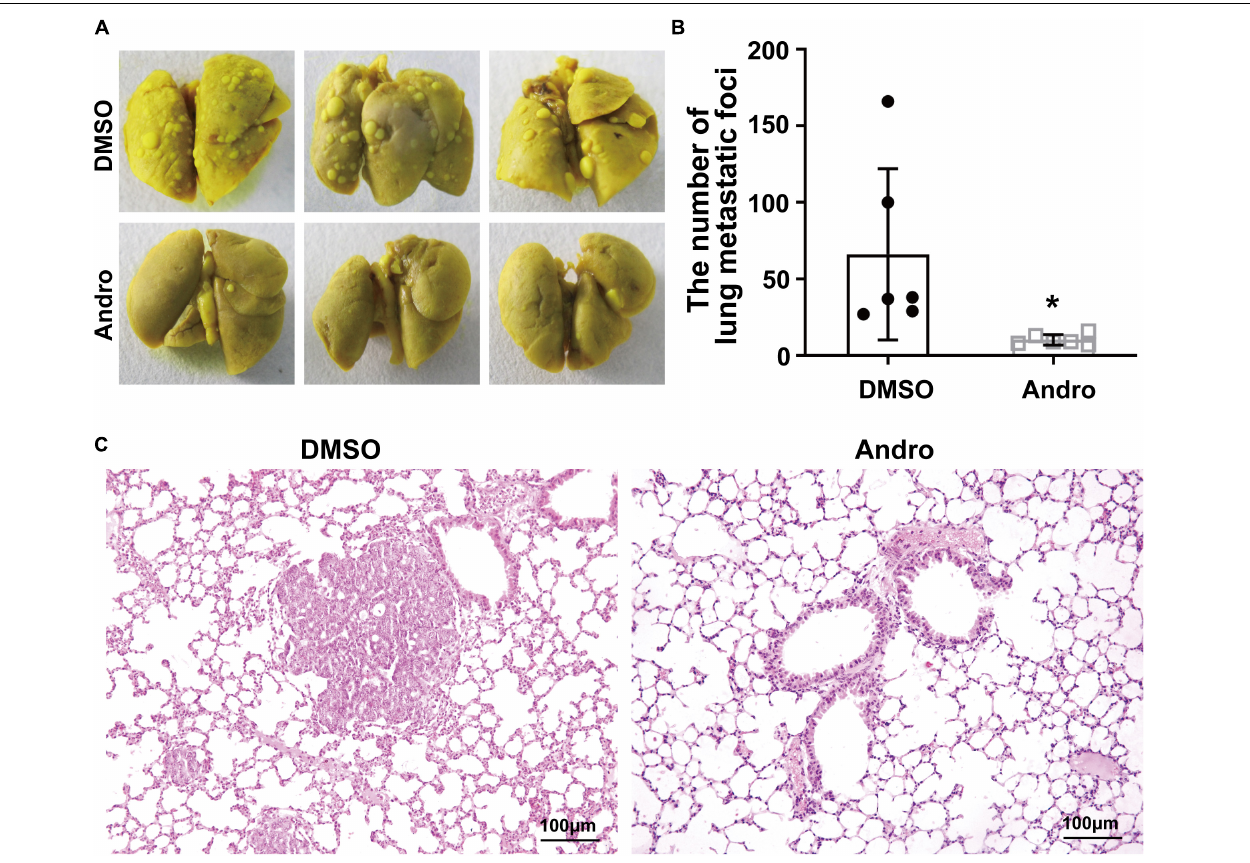
FIGURE 3 | Andrographolide (Andro) inhibits tumor metastasis to the lung in MMTV-PyMT mice. (A) Gross observation of metastatic foci on the surface of the lungs. (B) Quantification of metastatic foci. (C) Histological images of hematoxylin and eosin (H&E)-stained lung tissue sections. Quantitative data are expressed as the mean ± SD ( n = 6). Significant effect: * P <